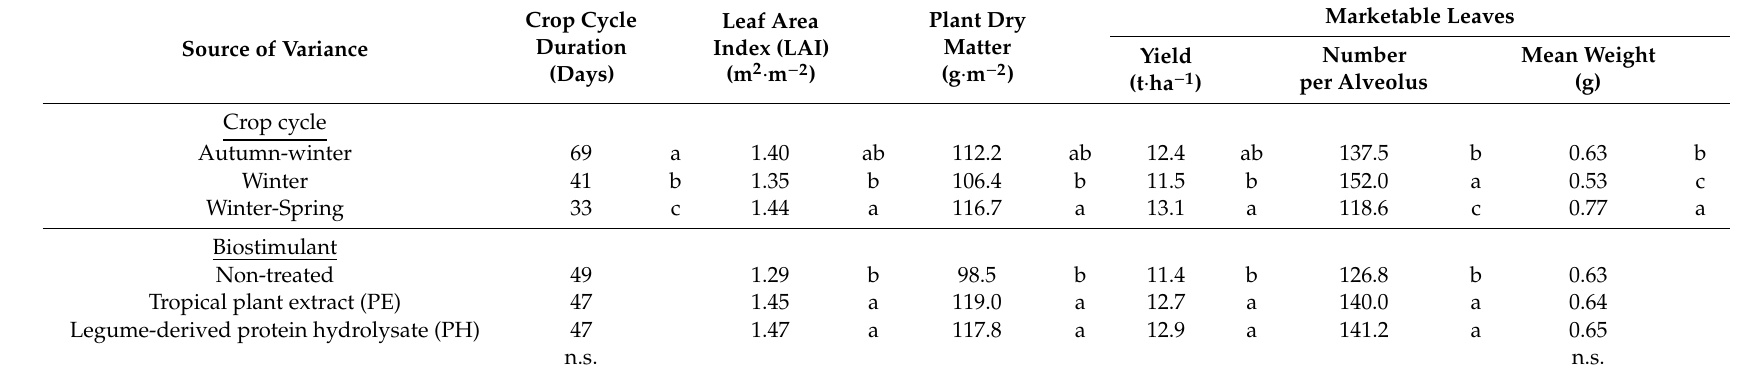
Table 1. Mean values of perennial wall rocket precocity, growth indices and yield components as a ff ected by crop cycle and biostimulant.